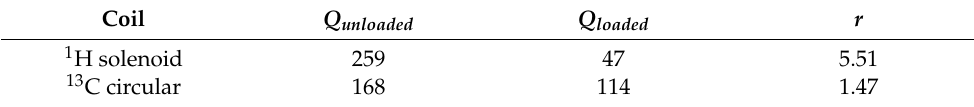
Table 2. The workbench results obtained for the two coils